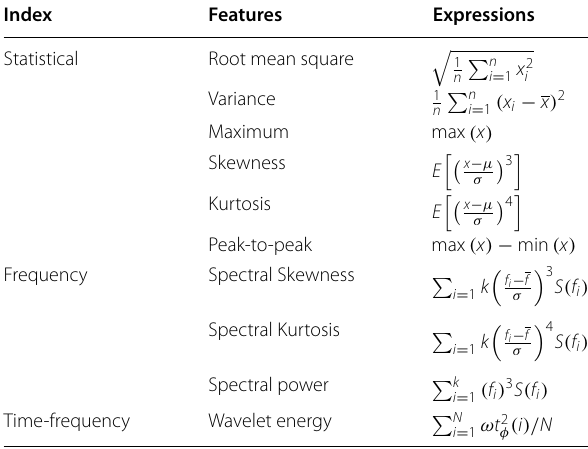
Table 3 Details of the extracted